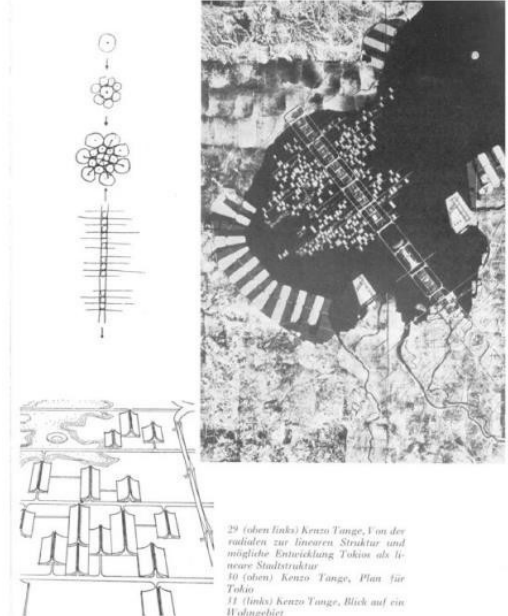
Figure 1. Tokyo Bay (1960) KenzoTange, with Kisho Kurokawa and Arata